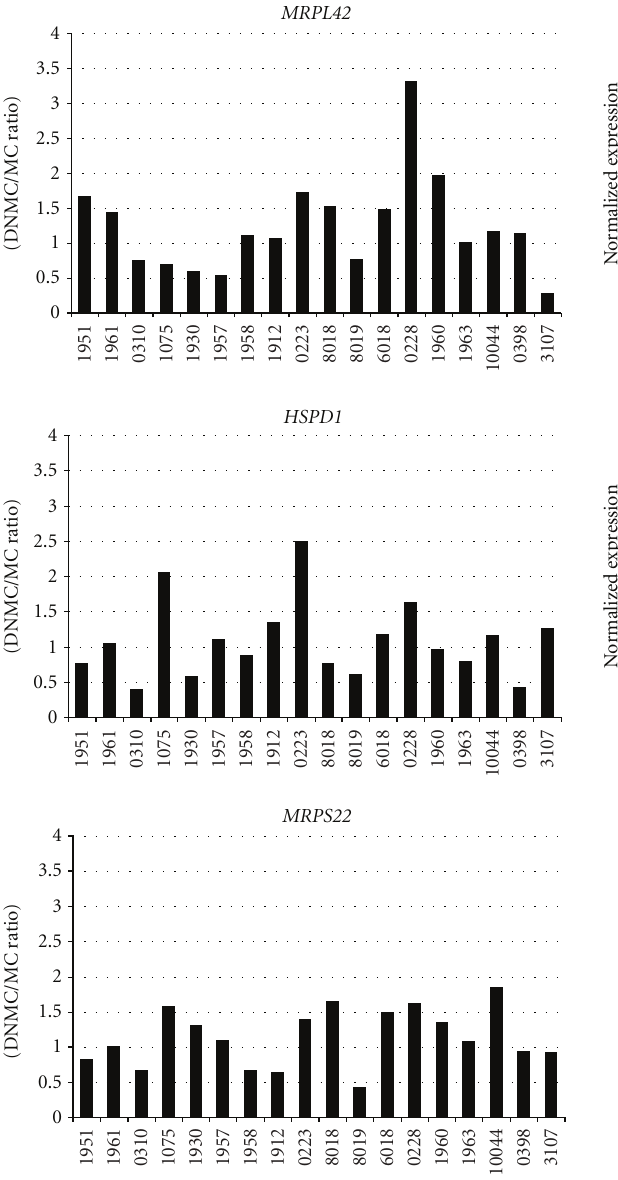
Figure 2: qPCR results across the 18 paired melanocyte sample groups for each of the five validated genes of the GO-based statistical analysis. Expression was calculated by taking the ratio between DNMC and the corresponding MC per patient sample set. RPS11 served as reference gene in qPCR experiments performed in duplicate. Values < 1: gene expression is lower in DNMCs when compared to normal skin-derived